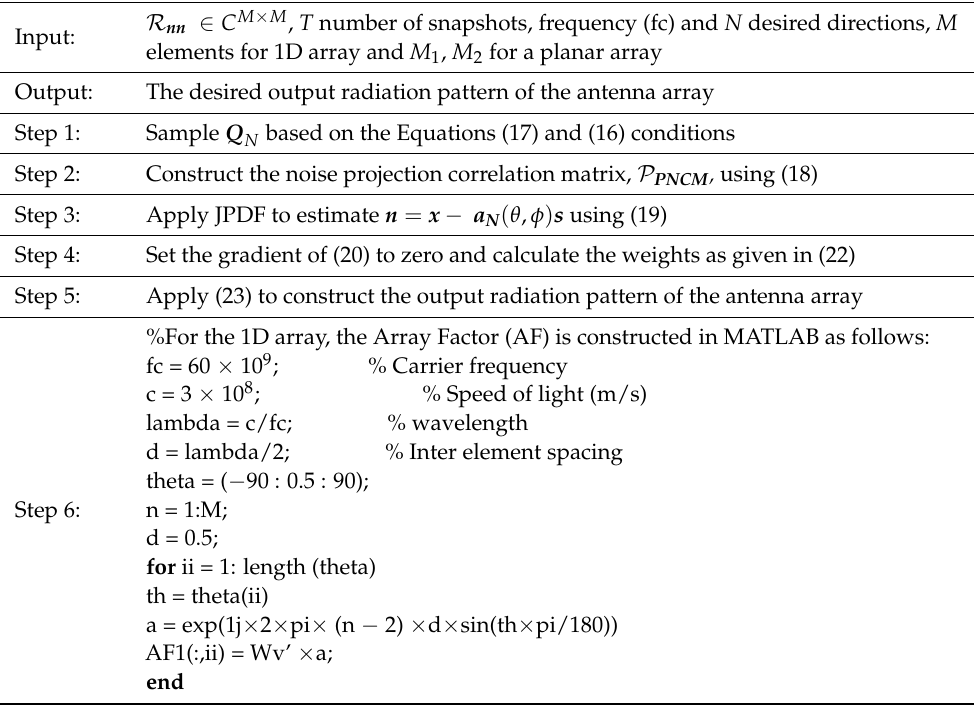
Algorithm 1 The simulation procedures of the proposed beamforming approach. Algorithm 1: Projection Noise Correlation